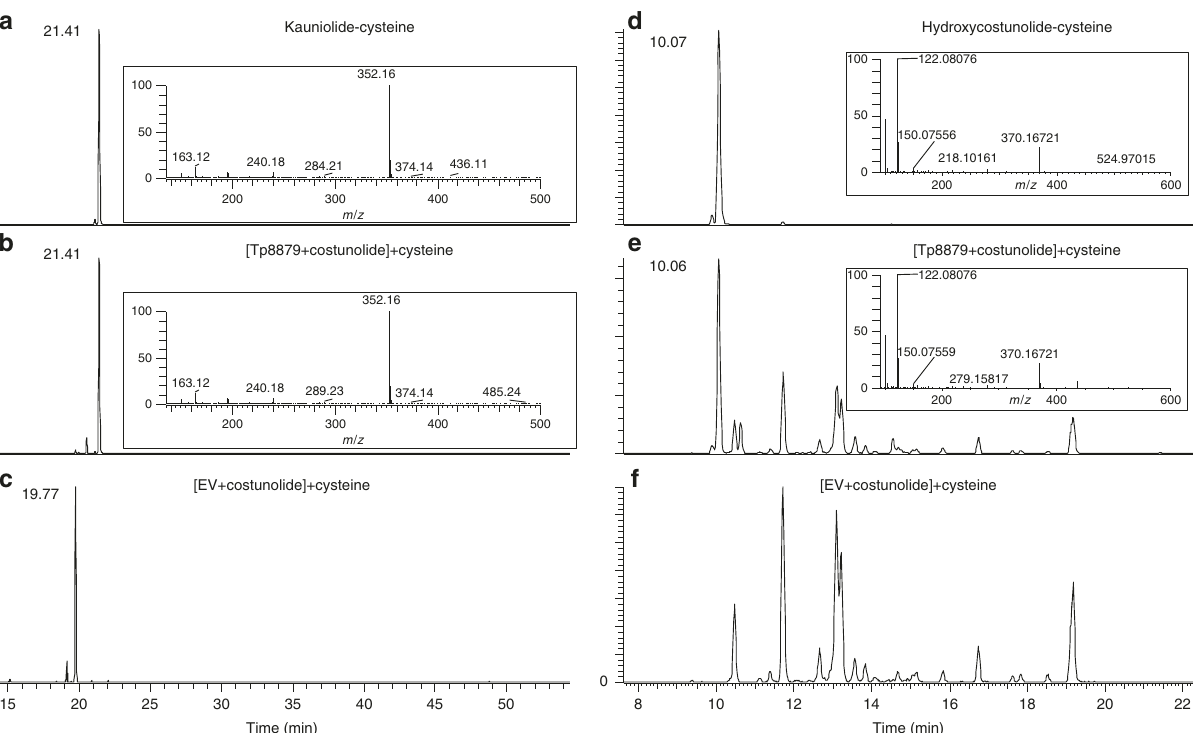
Fig. 2 Identi fi cation of kauniolide-cysteine in an assay with yeast microsomes using LC-Orbitrap-FTMS. a Incubation of kauniolide with cysteine. b Microsomes expressing Tp8879 (TpKLS) fed with costunolide and incubated with cysteine. c Negative control where no kauniolide-cysteine was formed by feeding costunolide to microsomes expressing an empty vector (EV) and incubation with cysteine. d Formation of 3 β -hydroxycostunolide-cysteine by incubating 3 β -hydroxycostunolide with cysteine. e LC-Orbitrap-FTMS chromatograms at m/z = 370.16827 (10 ppm, positive ionization mode, mass for 3 β - hydroxycostunolide-cysteine) of 3 β -hydroxycostunolide-cysteine formed in the enzymatic assay of feeding costunolide to TpKLS and incubated with cysteine. f Negative control where no 3 β -hydroxycostunolide-cysteine was formed by feeding costunolide to EV (microsomes of yeast with empty vector) and incubation with